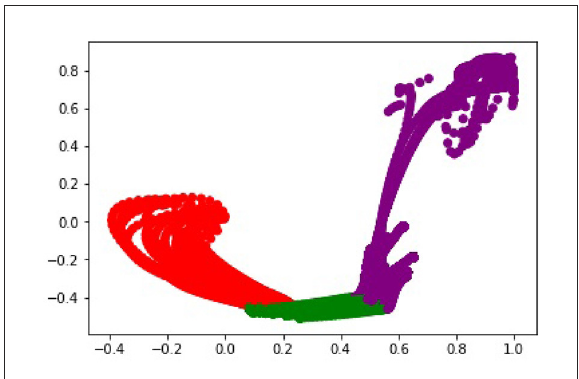
FIGURE7 The organization of the learned latent space associated with the Husky-UR5 dataset for reach, grasp, and lift (red, green, and purple, respectively).